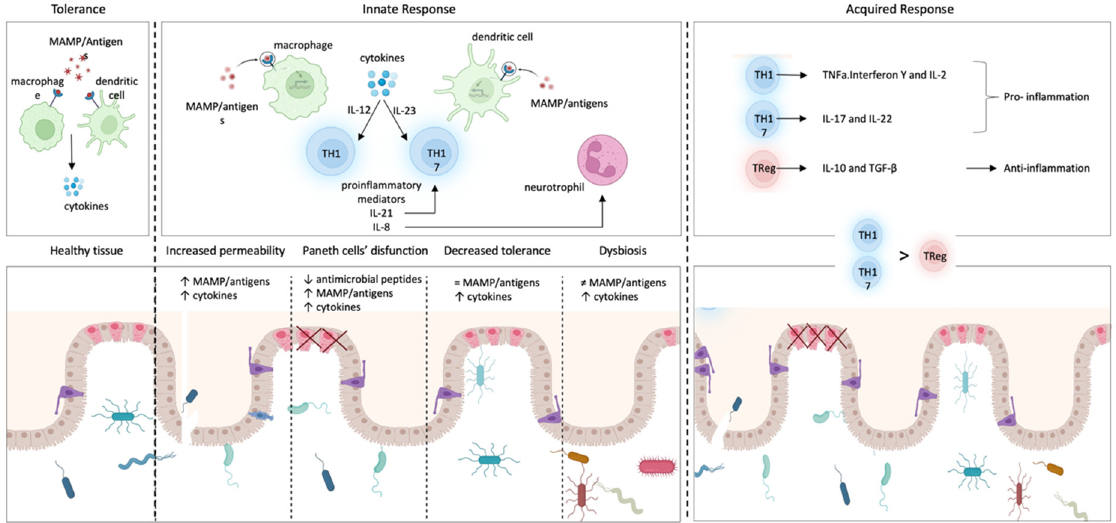
Figure 6. Immune-mediated process and inflammation in Crohn’s disease. The innate immune response acts as the first defense in the gastrointestinal tract. Specific cells of the immune system (macrophages, dendritic cells) can recognize these antigens and trigger an immune response, pro- ducing proinflammatory mediators that attract other immune cells to the site of inflammation and induce differentiation of undifferentiated T cells into Th1 or Th17. In Crohn’s disease, this response is triggered by: (1) increased permeability of the intestinal epithelium, (2) dysfunction of Paneth cells, which normally secrete antimicrobial peptides to maintain the microbiota, (3) decreased tolerance of dendritic cells and macrophages to antigens found in the intestinal lumen. Under normal conditions, the cells of the immune system communicate with the commensal microbiota through molecular recognition patterns (MAMPs) recognized by specialized receptors (4) dysbiosis of the gut microbiota. The acquired immune response is characterized by an imbalance of lymphocytes due to an increased number of Th cells in the mucosal lamina propria. Th lymphocytes generate pro-inflammatory molecules that, in turn, cause regulatory T lymphocytes to release anti-inflammatory factors.